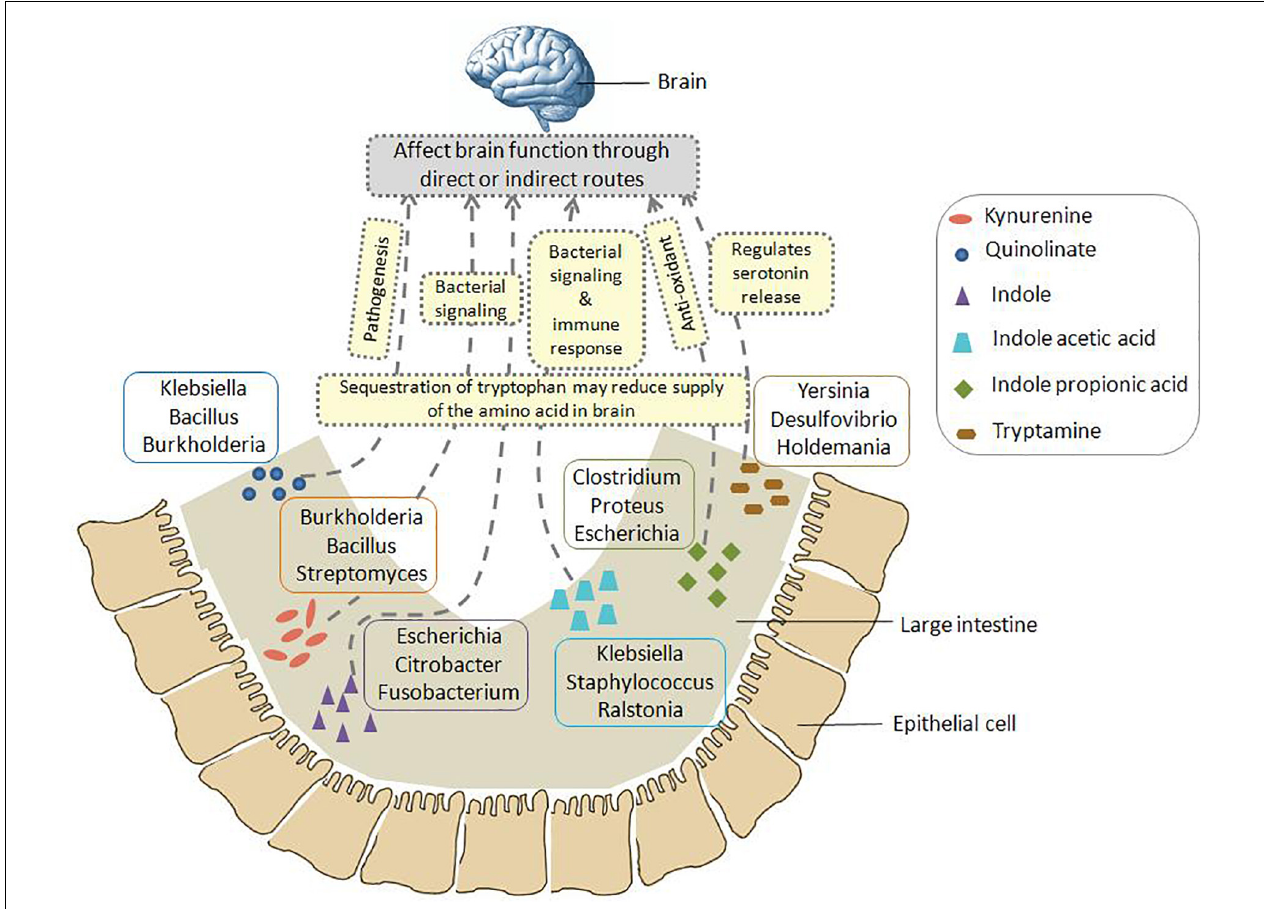
FIGURE 6 | Schematic representation of the insights obtained from genomic analysis in context of tryptophan metabolism pathways in gut bacteria and their probable connection to brain. The six neuro-active compounds produced through bacterial tryptophan metabolism are depicted using various shapes as shown in the legend provided inside the figure. For each compound, the top three genera with respect to the “SCORBPEO” value are shown within rectangles having solid borders. For example, bacterial genera such as Klebsiella , Staphylococcus , Ralstonia , etc., produce indole acetic acid (IAA) in the large intestine through tryptophan metabolism. Probable ways by which each of the six compounds may alter the functioning of GBA (as collated from literature) have been indicated by yellow rectangles having dotted border. For instance, IAA may affect the interaction between gut and brain by acting as inter-cellular signaling molecule and immune system modulator. Apart from such mechanisms mediated by tryptophan metabolism products, sequestration of tryptophan by gut bacteria may have a direct impact on brain tryptophan level, which in turn can affect brain function.